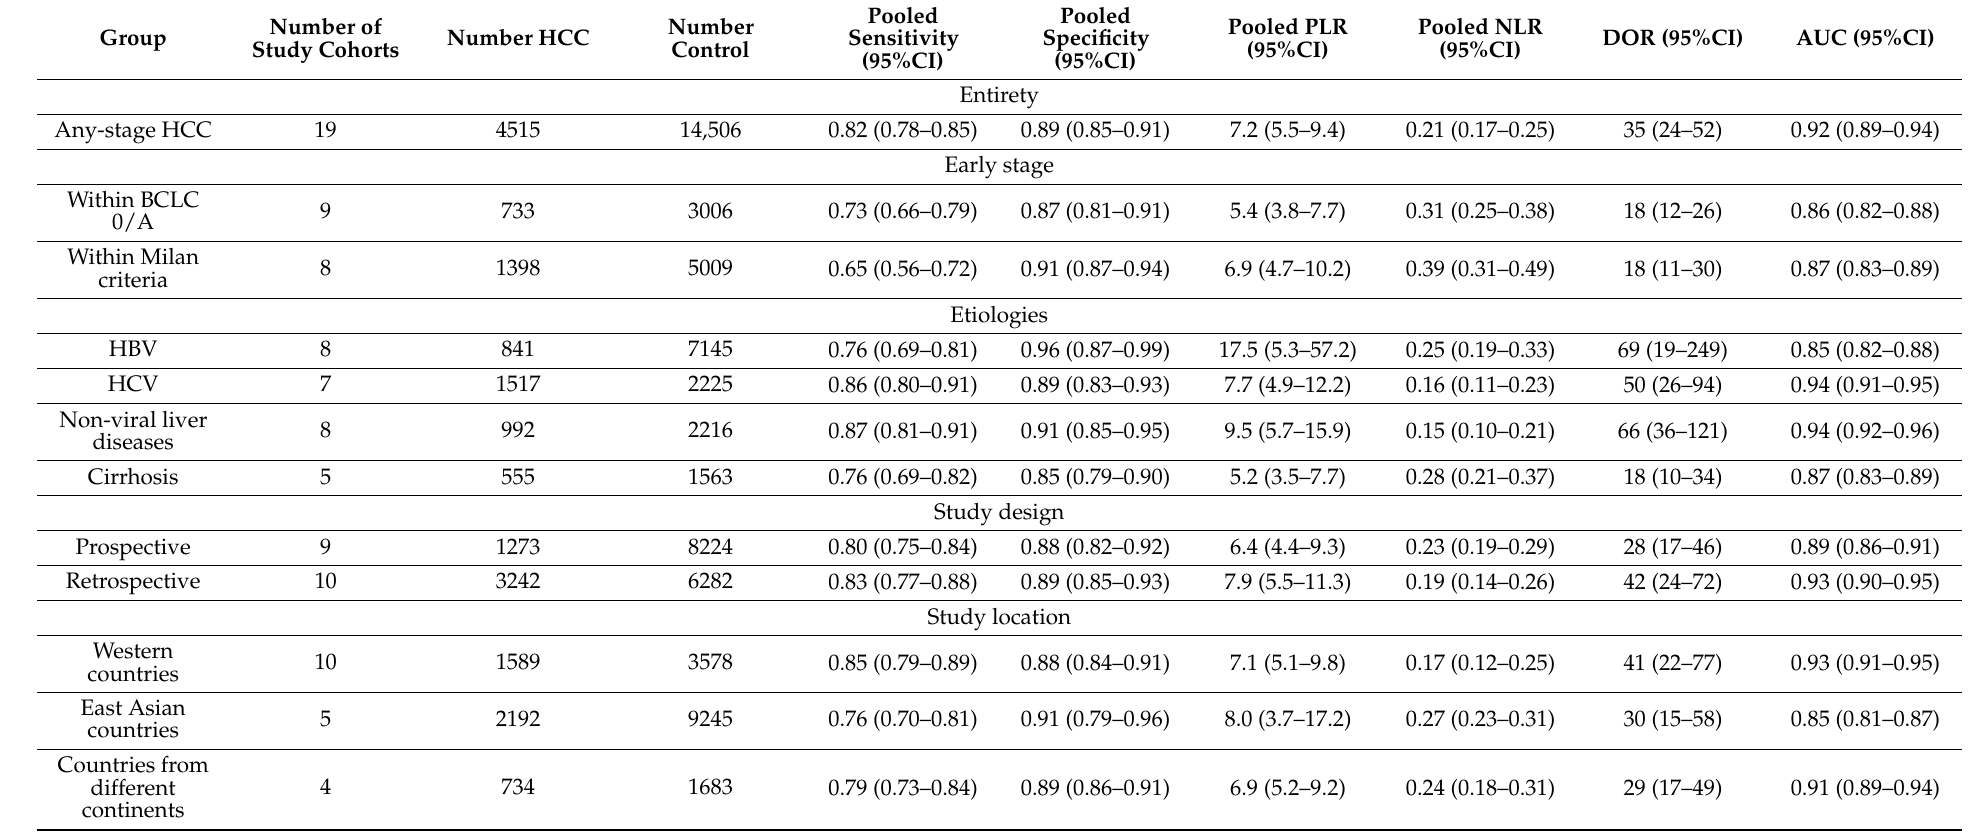
Table 3. Statistical analyses of GALAD score for discriminating HCC in different